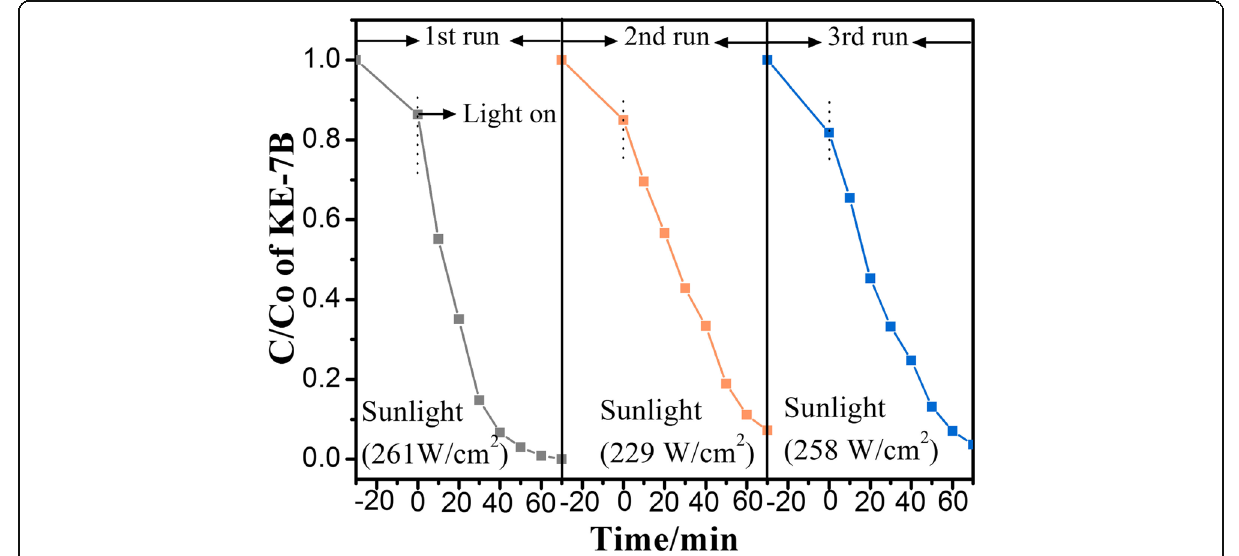
Fig. 10 Cycling test of adsorption and sunlight-driven photocatalytic degradation for ZB_0.01, displaying tolerable